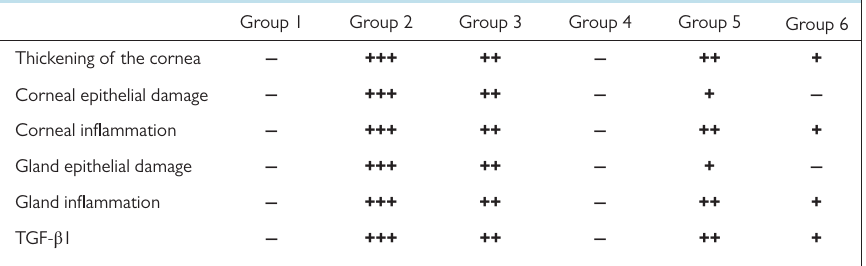
Table 1. Scoring of Histopathological and Immunohistochemical Findings in Eye and Tear Gland